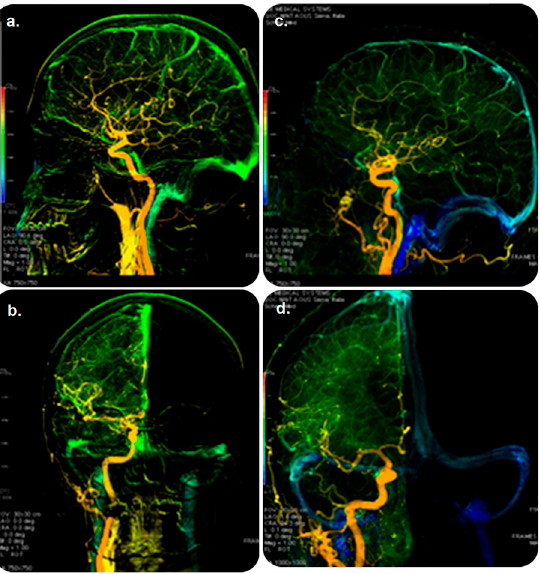
Figure 3. AngioViz software and its role in guiding therapy. DSA examination: ( top ) lateral and ( bottom ) anterior–posterior views of color-coded right carotid artery in controls ( a , b ) and patients ( c , d ) with multiple sclerosis. Blue color shown only in patients demonstrates prolonged cerebral circulation time. Veins are in green (and not in blue) in the controls ( a , b ). Abbreviations: DSA, digital subtraction angiography. Reprinted from “Cerebral circulation time is prolonged and not correlated